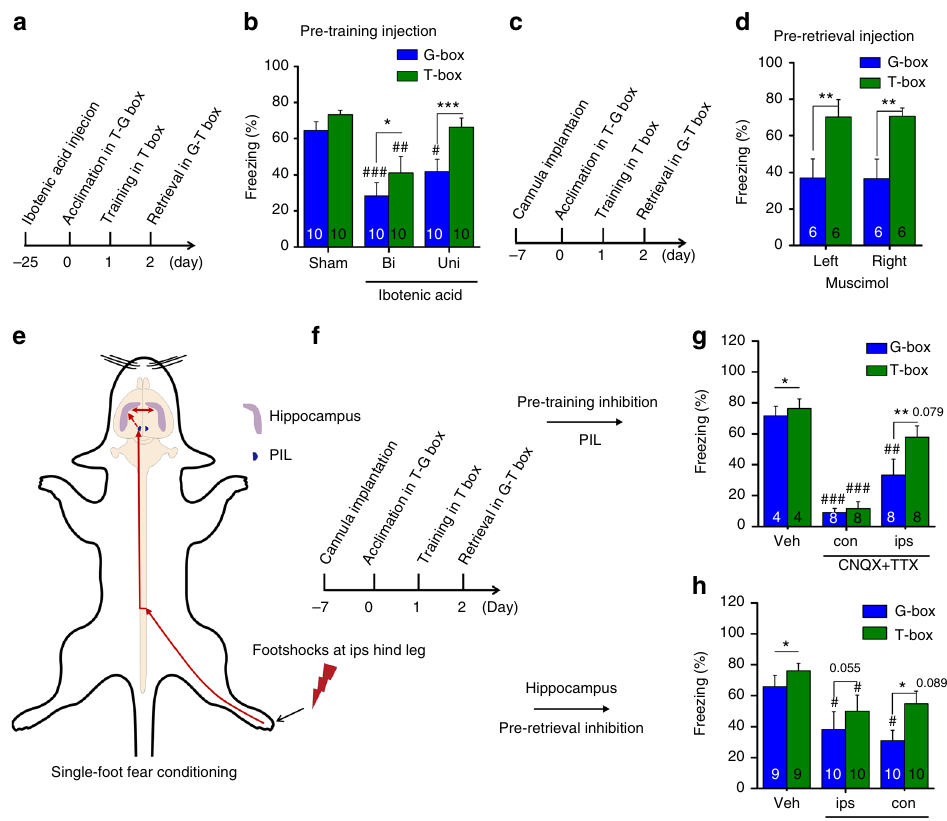
Fig. 2 Bilateral CA1 are required symmetrically for generalization. a Paradigm for studying CA1 lesion effects by using ibotenic acid. b Unilateral (Uni) CA1 lesion impaired generalization, but bilateral (Bi) CA1 lesion impaired both fear memory and generalization relative to Sham control. c Paradigm for studying inhibition effects of CA1. d Inhibition of left or right CA1 before retrieval tests by using muscimol impaired generalization near equally. e , f Schematic of single-foot fear conditioning and studying paradigm. g Inhibition of ipsPIL before fear conditioning by using CNQX + TTX impaired generalization, with nonsigni fi cant effect on fear memory relative to Veh, but that inhibiting conPIL impaired both fear memory and generalization. h Using this single-foot paradigm, however, inhibition of ipsCA1 or conCA1 before retrieval tests impaired generalization similarly, while ipsCA1 or conCA1 inhibition caused nonsigni fi cant reduction of fear memory relative to Veh. Statistical comparisons are performed by using two-way ANOVA (*contrast effects for G-box vs. T-box; # parameter estimates for control vs. treatment); * or # P < 0.05, ** or ## P < 0.01, *** or ### P < 0.001. Error bars, s.e.m. PIL, the